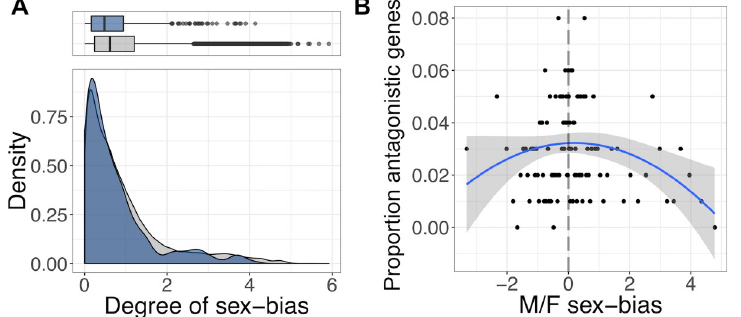
Fig 3. Sex-biased gene expression among antagonistic genes. (A) Distributions of the absolute degree of sex-biased expression for antagonistic (blue) and nonantagonistic (grey) genes. (B) Proportion of genes that are antagonistic across bins of expression sex bias (100 genes per bin). Points represent mean expression level in each bin. Blue curve ( ± SE) shows the best-fit quadratic model for the relationship between antagonism and expression sex bias. Data and code underlying this figure can be found at https://doi.org/10.5281/zenodo.2623225. F, female; M, male.